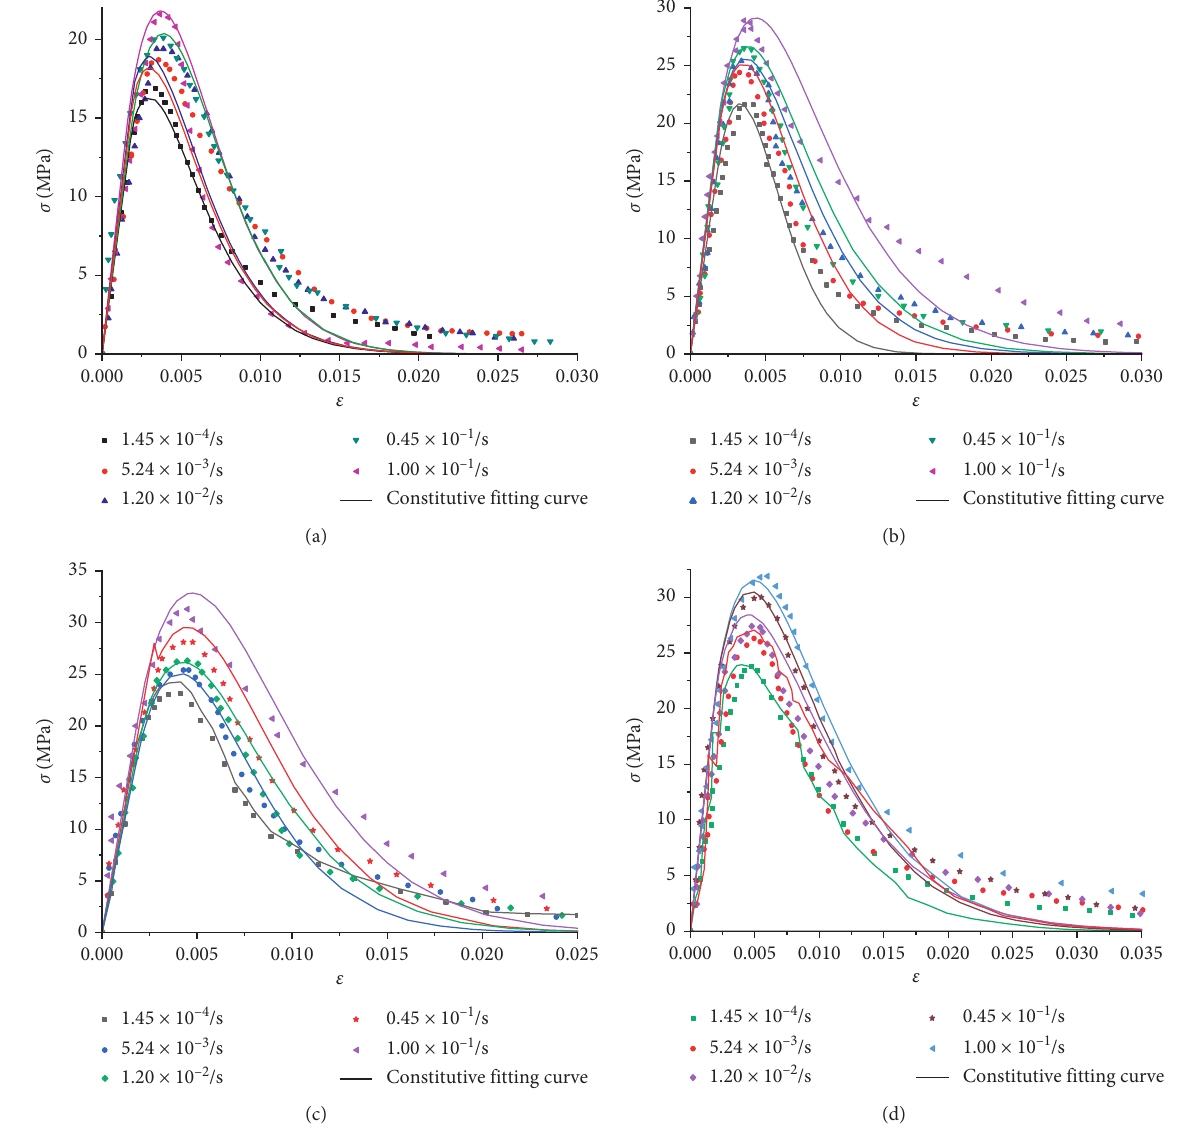
Figure 13: Constitutive fitting of PFRC at different strain rates. (a) V